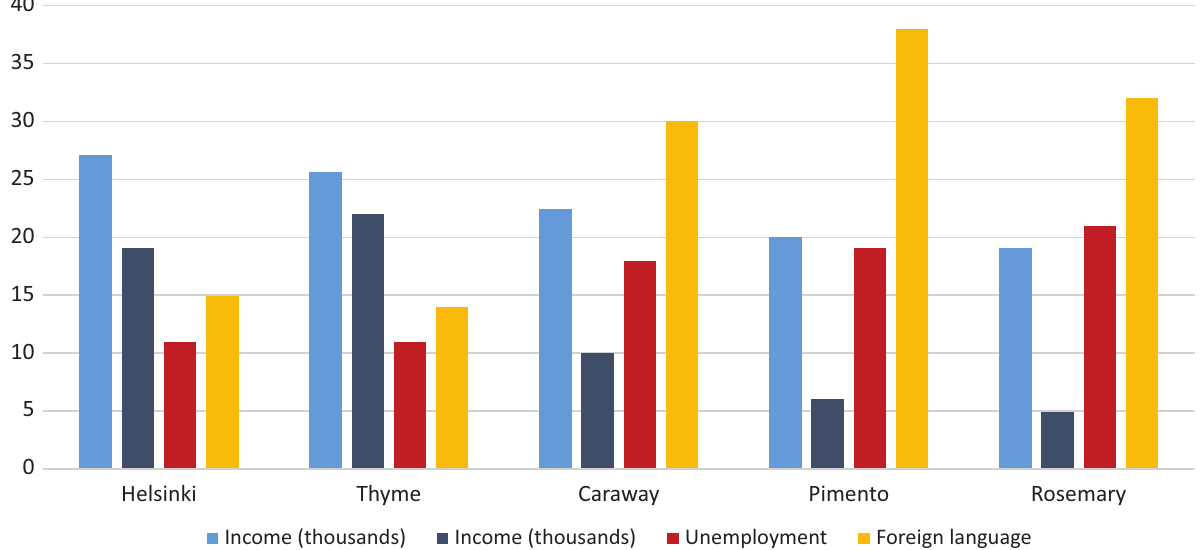
Figure 1. Socio-economic characteristics of all school catchment areas (Helsinki, average) and the case study school catch- ment areas: Average yearly income (thousands) and share of residents with master’s-level tertiary education, share of unemployed residents and residents with a foreign mother tongue (other than Finnish, Swedish or Samí) in